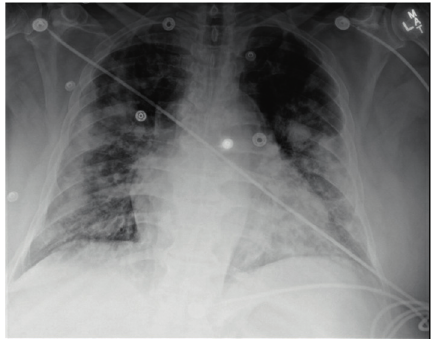
Figure 3: Chest X-ray on day 14 showing worsening bilateral infiltrates.